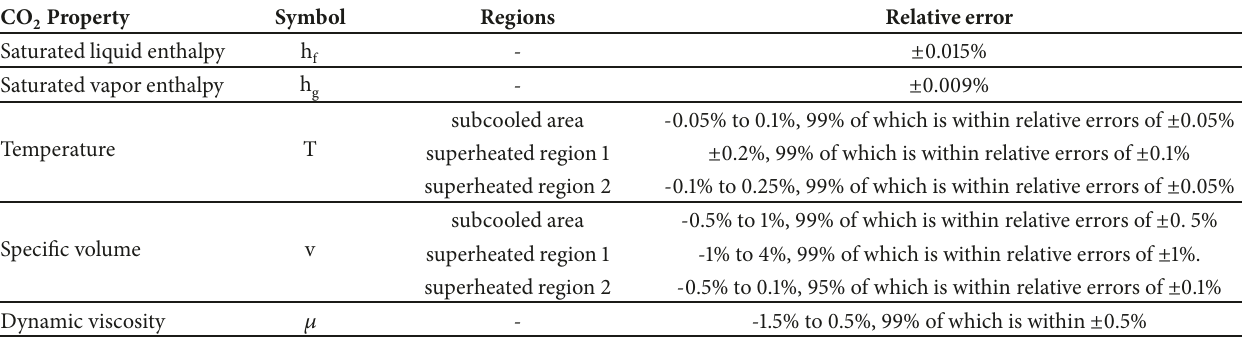
Table 2: Relative prediction error of the developed CO 2 property package compared to NIST REFPROP